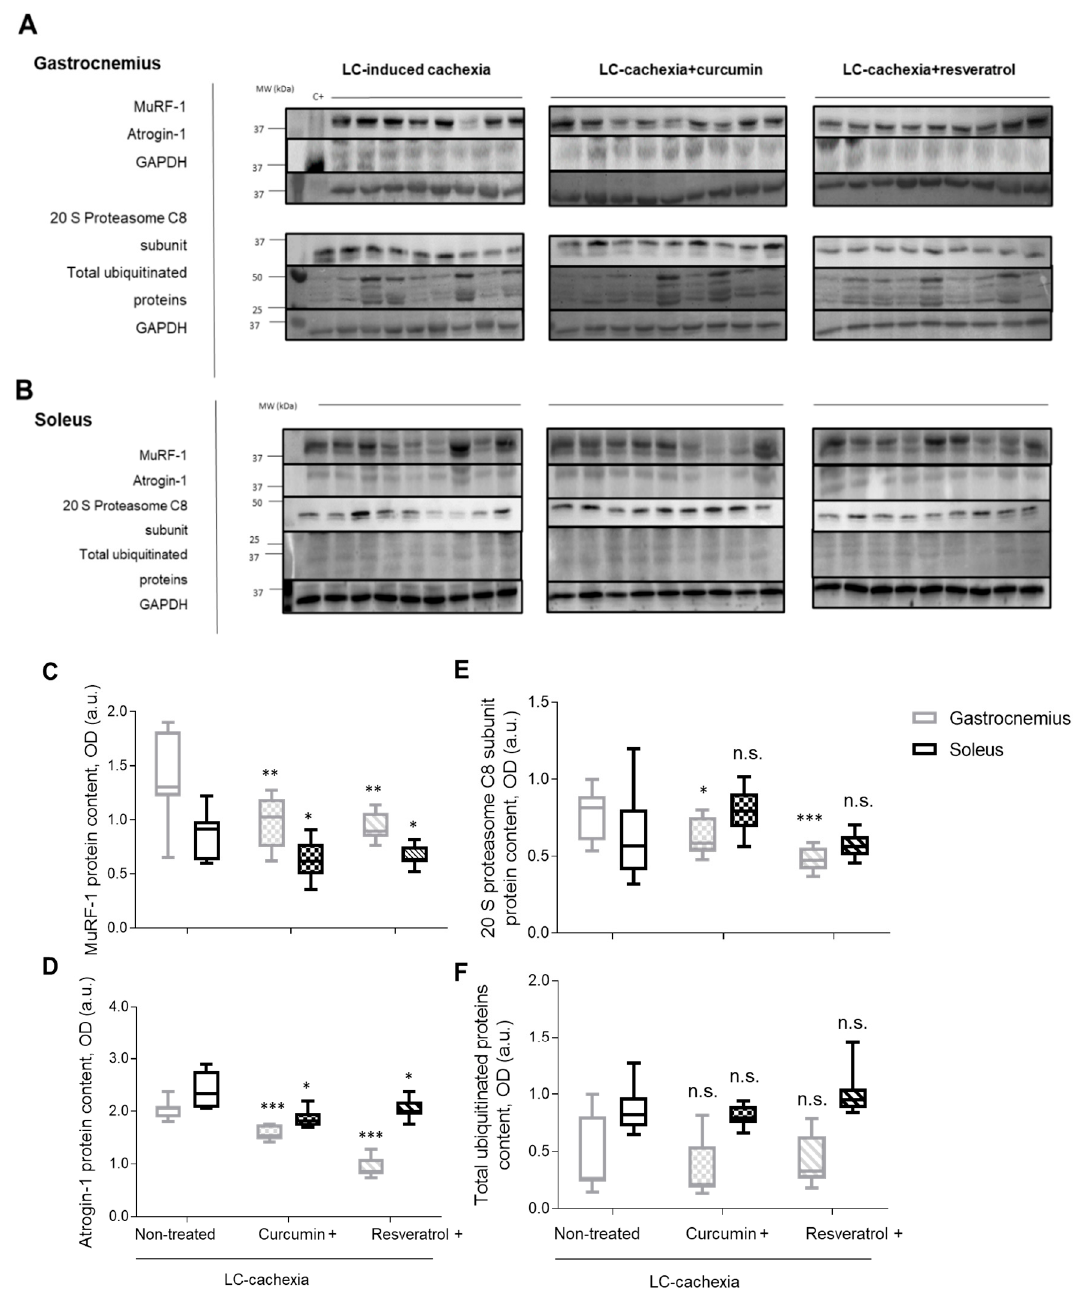
Figure 7. Representative immunoblots of C8-20S, total ubiquitinated proteins, MuRF-1, Atrogin-1, and GAPDH protein content in the gastrocnemius ( A ) and soleus ( B ) muscles of all study groups of mice. Box plots of MuRF-1 ( C ), Atrogin-1 ( D ), 20S subunit of the C8 proteasome marker ( E ), and total ubiquitinated proteins ( F ) protein content in gastrocnemius and soleus muscles of the different study groups of mice, as measured by optical densities in arbitrary units (OD, a.u.). (Definition of abbreviations: OD, optical densities; a.u., arbitrary; MW, molecular weight; kDa, kilodalton; LC, lung cancer; C8-20S, 20S proteasome alpha subunit; MuRF-1, muscle ring finger protein 1; GAPDH, glyceraldehyde-3-phosphate dehydrogenase. Statistical significance is represented as follows: *, p ≤ 0.05; **, p ≤ 0.01; ***, p ≤ 0.001, ns, non significant, between any of the study groups and the LC-induced cachexia mice in gastrocnemius and soleus